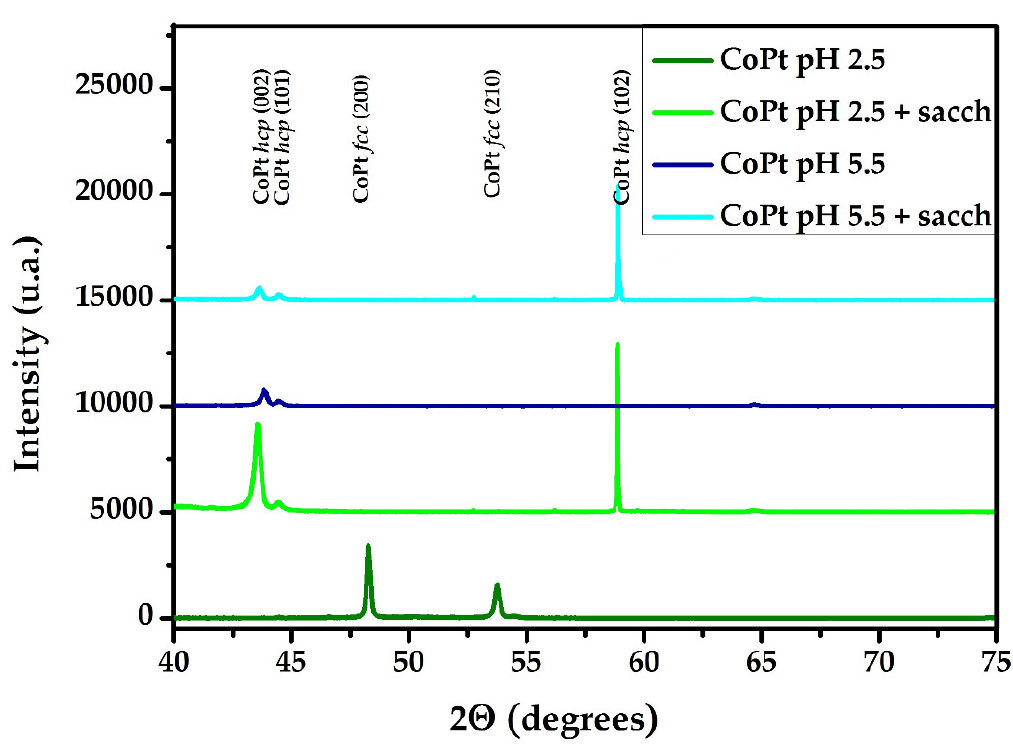
Figure 5. XRD patterns of CoPt alloys are prepared in different solutions.